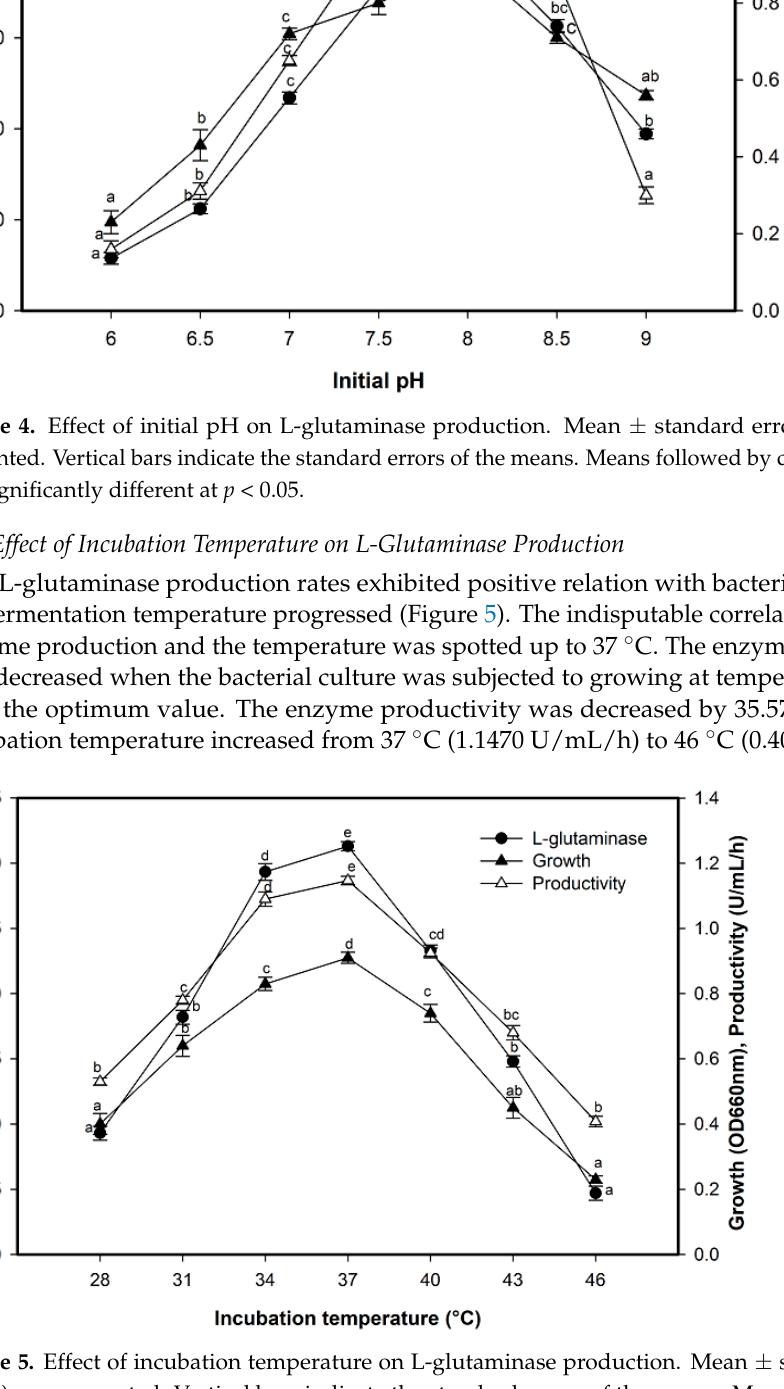
( n = 3) was presented. Vertical bars indicate the standard errors of the means. Means followed by different letters are significantly different at p < 0.05.